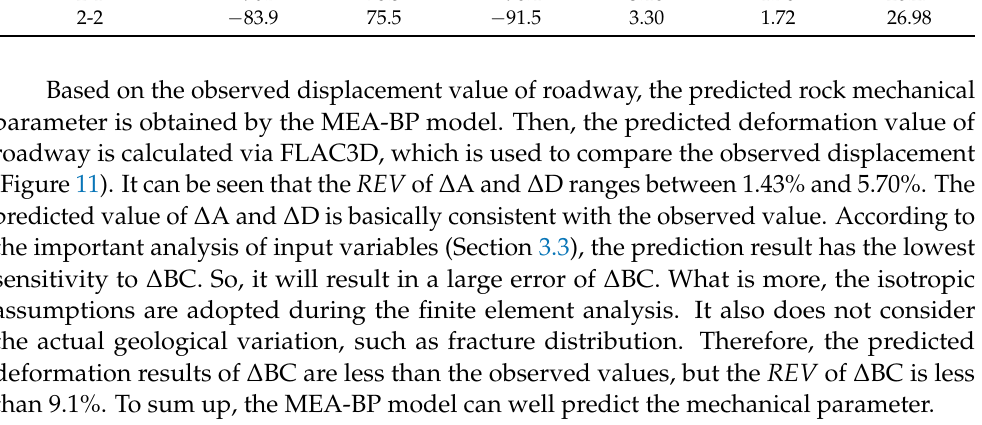
Table 6. The deformation and predicted mechanical parameters of roadway.